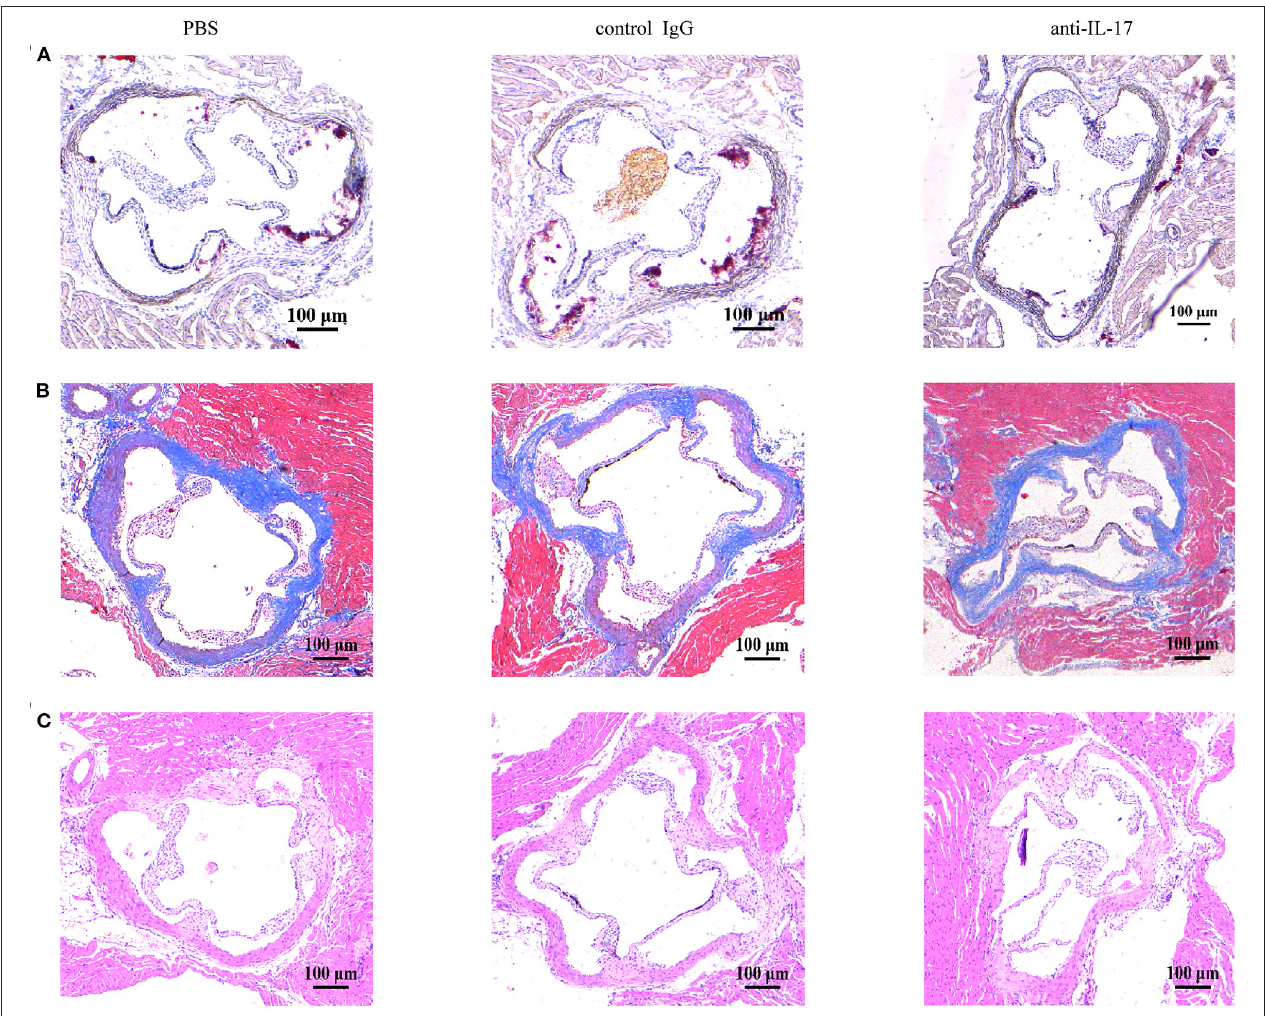
FIGURE 4 | The severity of atherosclerosis after IL-17 neutralization. Representative images of aortic roots stained with (A) Oil Red O stain, (B) Masson trichrome stain, and (C) hematoxylin–eosin